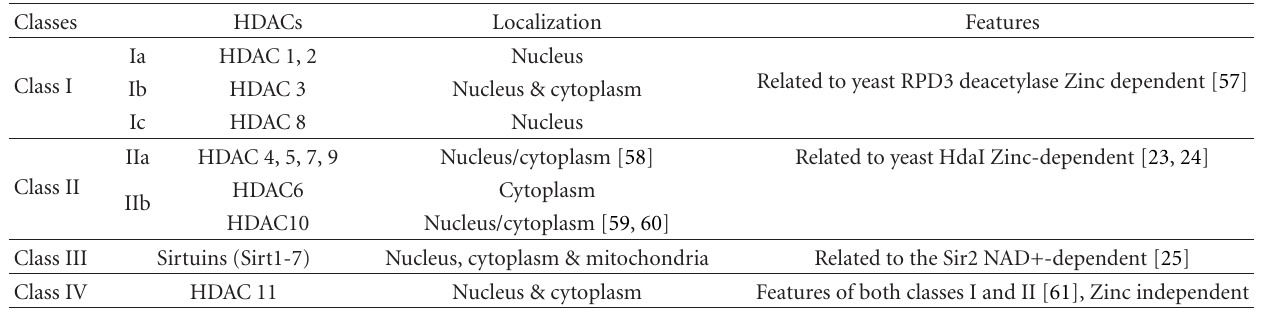
Table 1: Histone deacetylases: Classification and